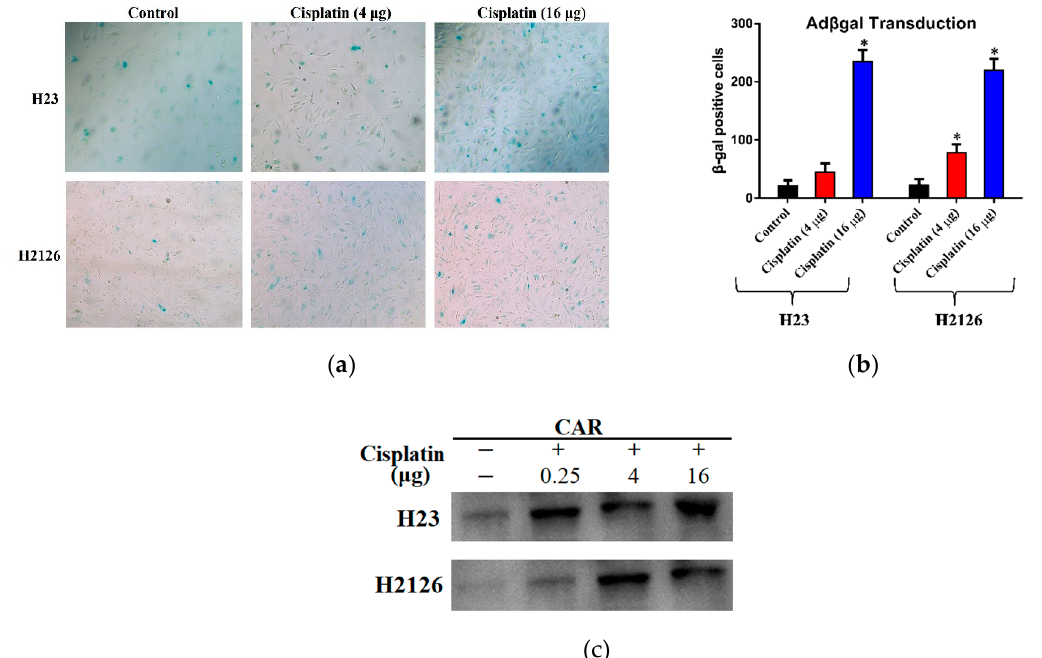
Figure 3. Effect of cisplatin treatment on CAR levels and adenoviral transduction. ( a ) Lung cancer cell lines, H23 and H2126, were treated with different cisplatin doses and observed for CRAd infection efficacy through X-gal staining. Cells were cultured in 6-well plates and treated with different Ad β gal doses. After 48 h, all cells were washed, fixed, and stained and observed under the phase-contrast microscope (100× magnification). ( b) Cells exhibit higher rates of transduction at high doses of cisplatin. (c) Western blots showing CAR overexpression in cancer cell lines pre-treated with cisplatin. Data are presented in (b) as the mean ± SD, ( n = 3), * p <0.01, by two-tailed Student’s t-test.